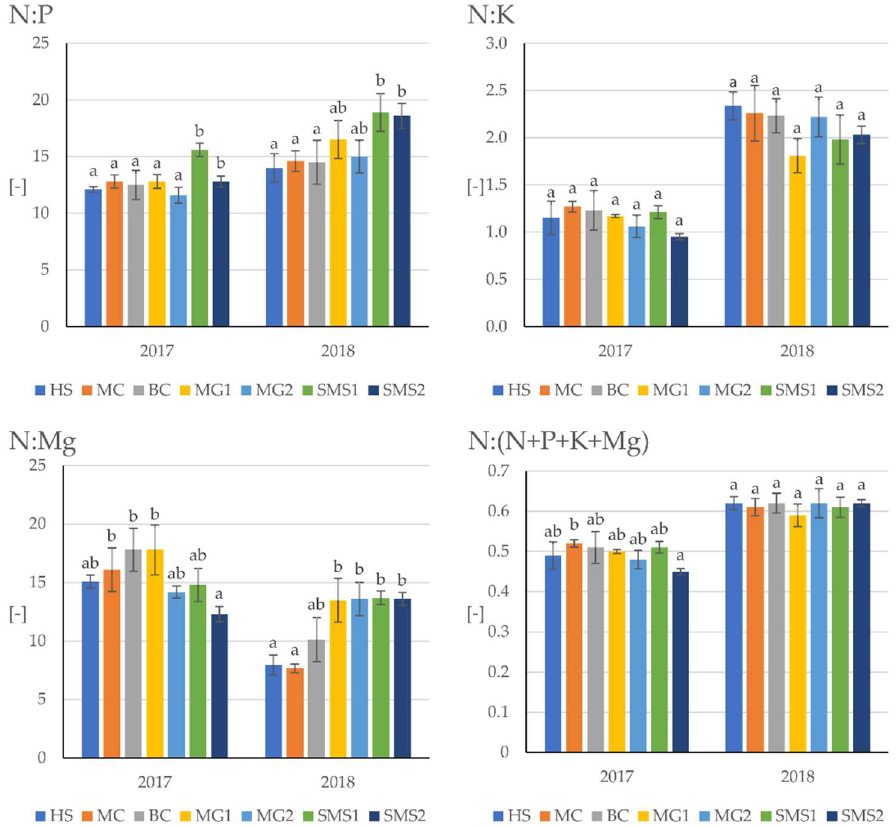
Figure 3. Macro-nutrient ratios in ‘Red Jonaprince’ apple leaves calculated for elements chosen depending on the floor management system used. Letters over bars indicate significant differences between treatments within a year according to the Newman–Keuls post hoc test at p ≤ 0.05.